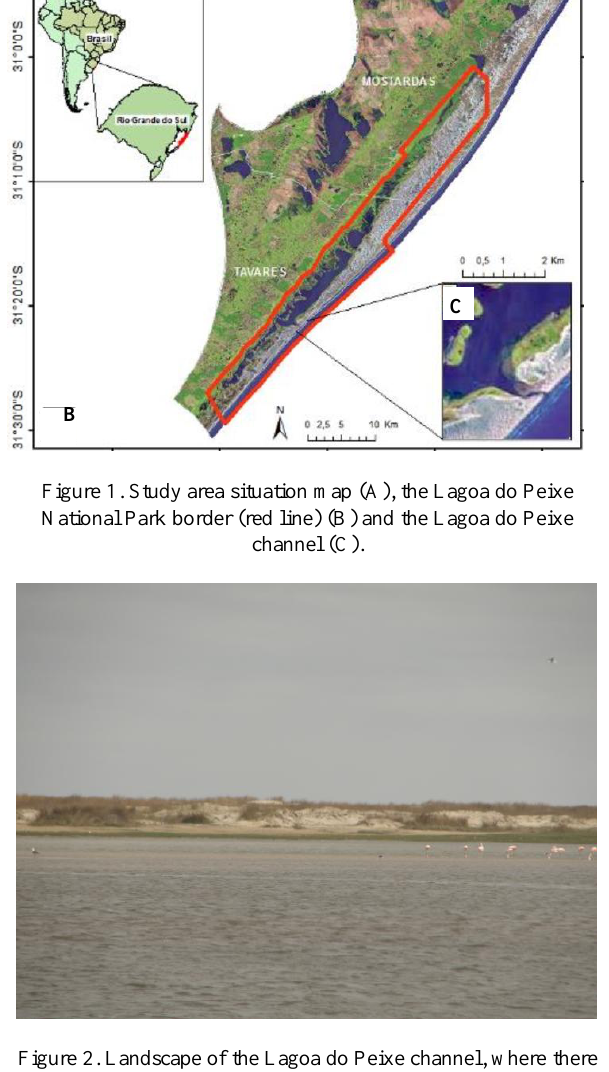
Figure 2. Landscape of the Lagoa do Peixe channel, where there can be noticed the migrant birds (flamingos) and the surroundings with vegetated banks.